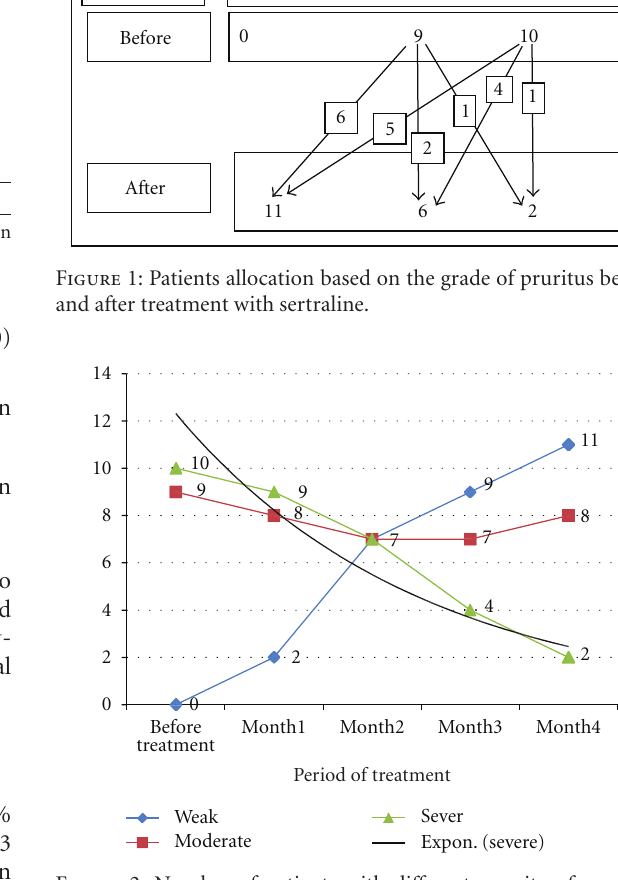
Figure 2: Number of patients with di ff erent severity of pruritus during treatment with